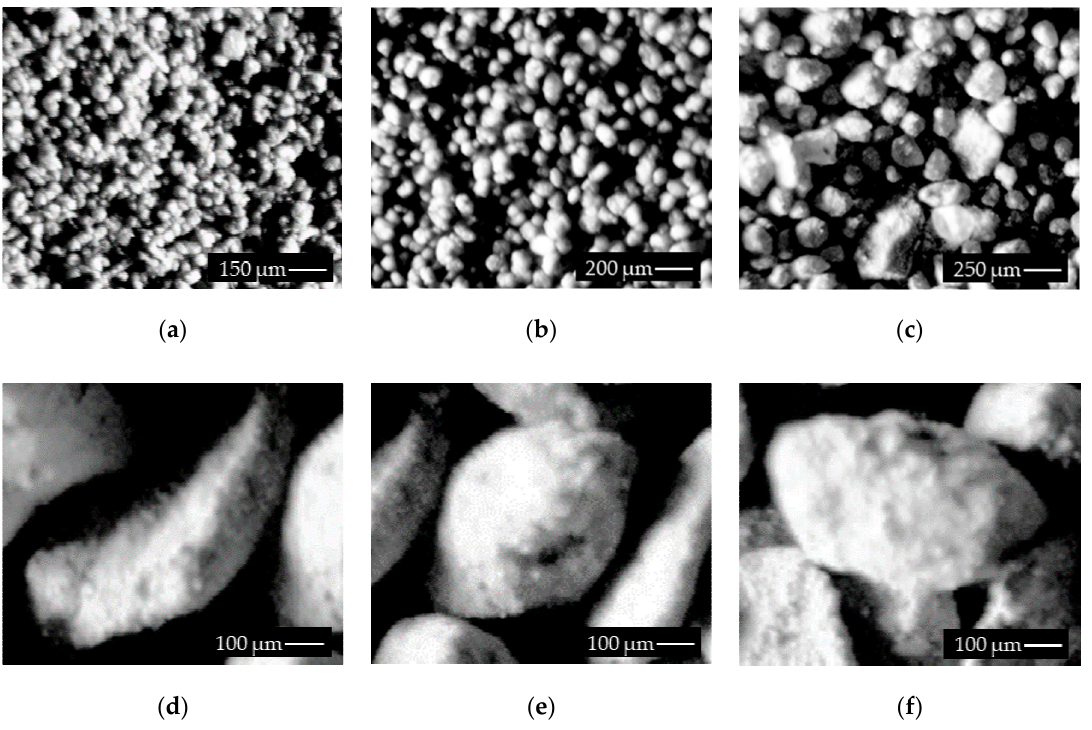
Figure 7. Real images of tested samples ( a–c ), grains with 0.75 mm granularity fraction ( d–f ).